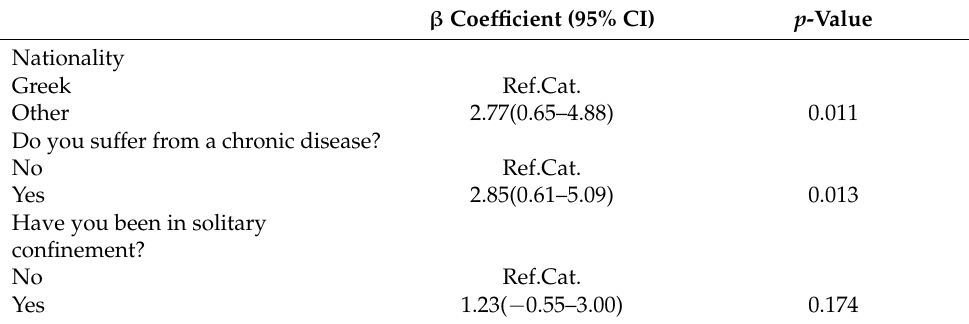
Table 7. Impact of inmates’ characteristics on their